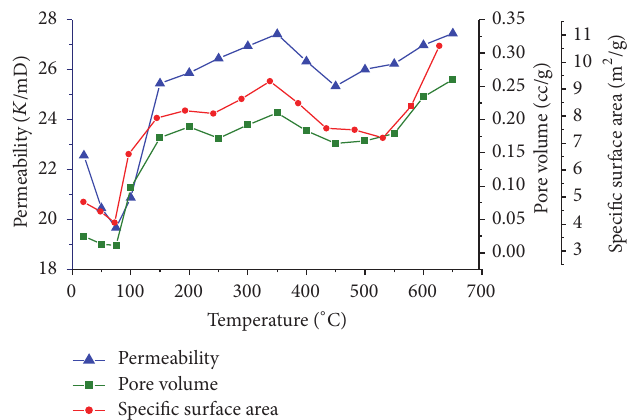
Figure 14: Variation of the permeability, specific surface area, and pore volume with temperature.